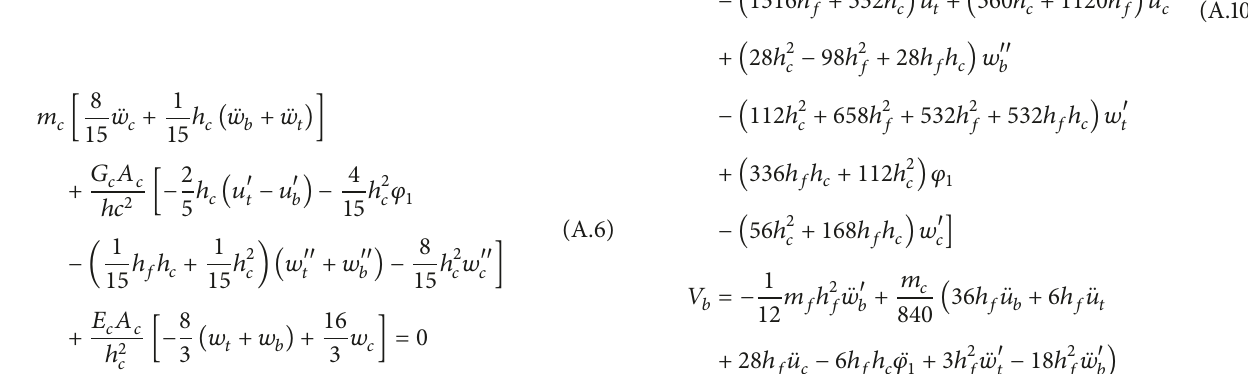
Figure 9: Vibration amplitude of cantilever sandwich beam for different core thicknesses by